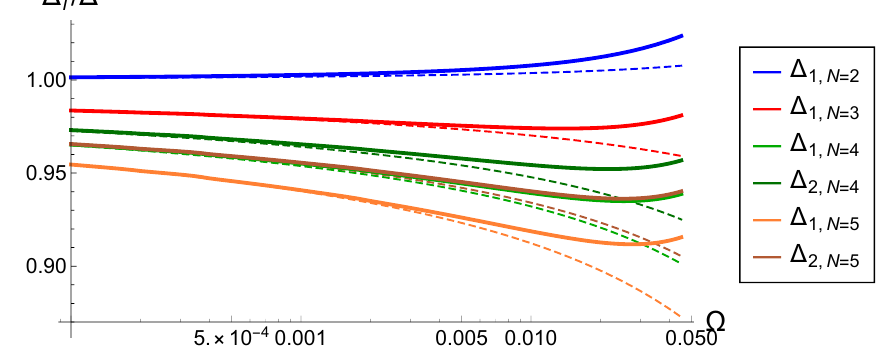
(cid:0) (cid:1) 1 / ∆ 3 . The numerical data is produced by the same method